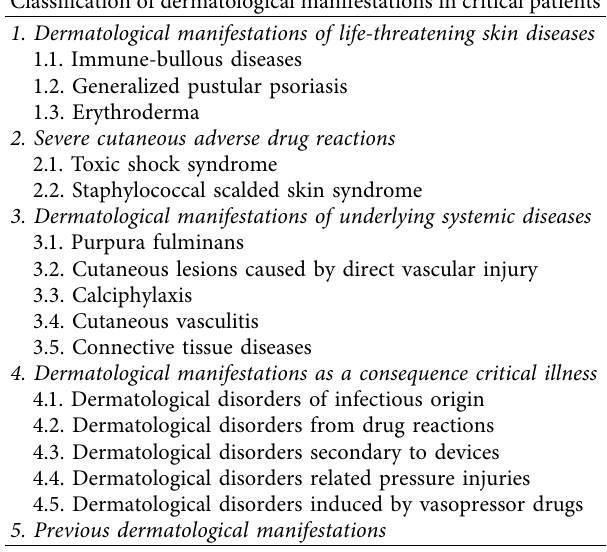
Table 1: Classification of dermatological manifestations in critical